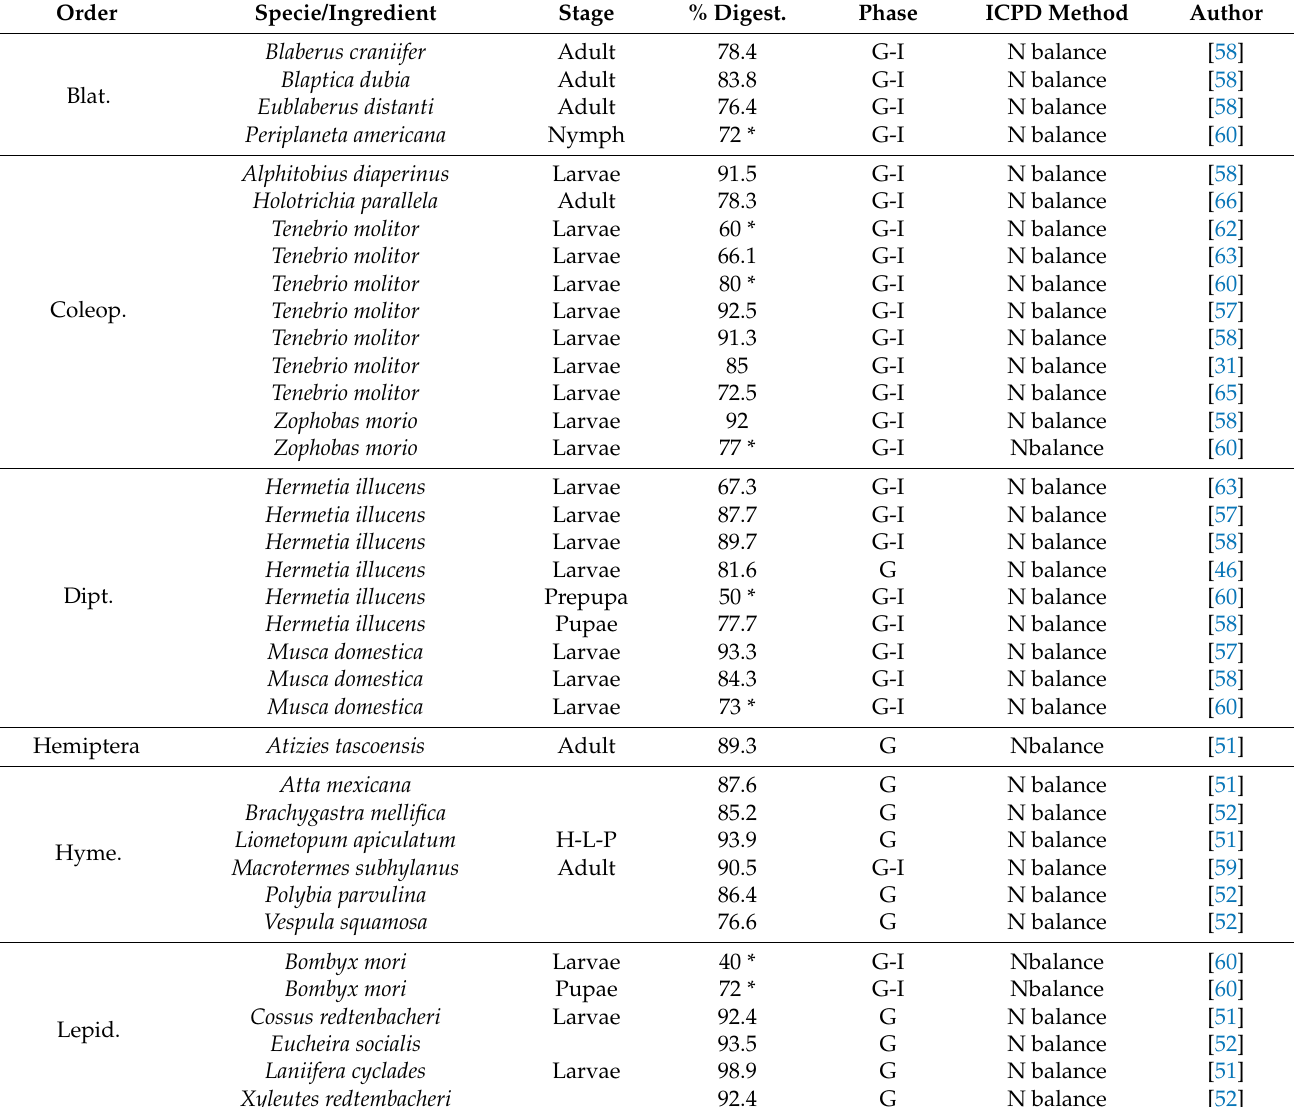
Table 3. In vitro crude protein digestibility of